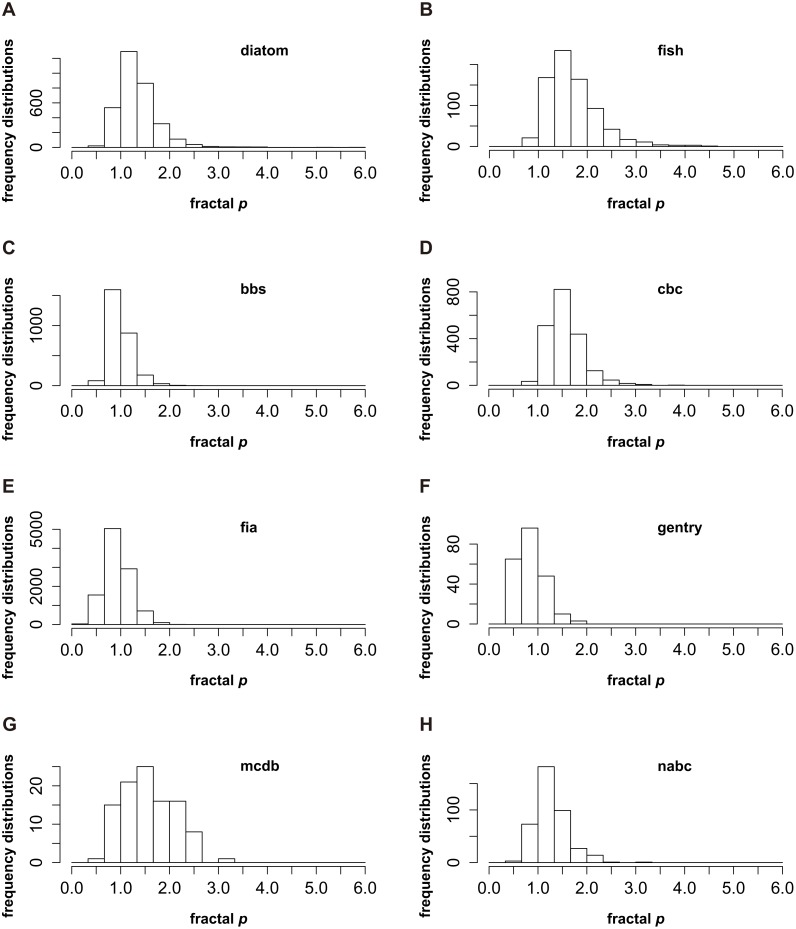
The frequency distributions of the fractal p (Su, 2016) for eight datasets (named “fish”, “diatom”, “nabc”, “mcdb”, “gentry”, “fia”, “cbc” and “bbs”) from two sources (Baldridge et al., 2016a; Baldridge et al., 2016b; Passy, 2016a; Passy, 2016b).The peaks of p frequencies for eight groups are not exactly the same. It could be from 0.67 to 1 (C, E and F), from 1 to 1.33 (A and H) and from 1.33 to 1.67 (B, D and G). However, the consensus of the p frequencies for every group is very clear. The fractal p mostly appears close to 1, and it is rare that p is far greater than 1 or very near 0.